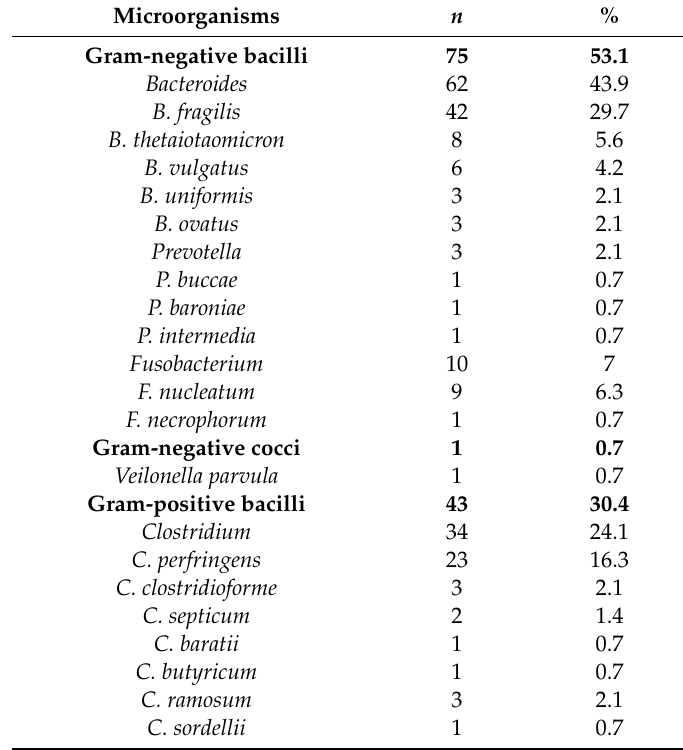
Table 2. Anaerobic microorganisms isolated from bloodstream